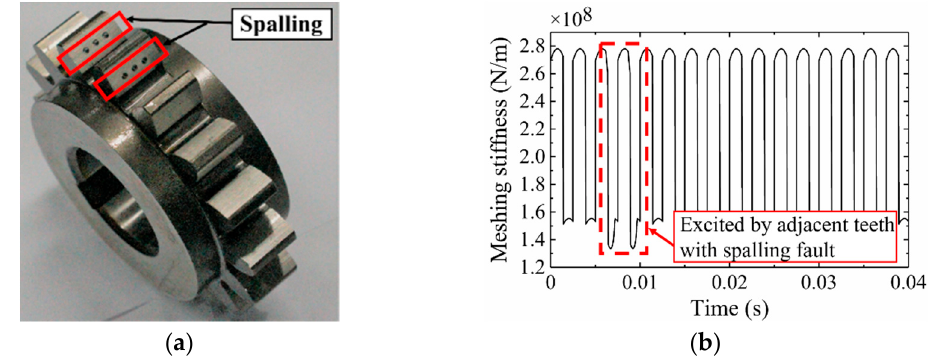
Figure 9. Status of tooth surface and mesh stiffness curves (adjacent teeth with spalling fault): ( a ) status of tooth surface and ( b ) mesh stiffness curves.